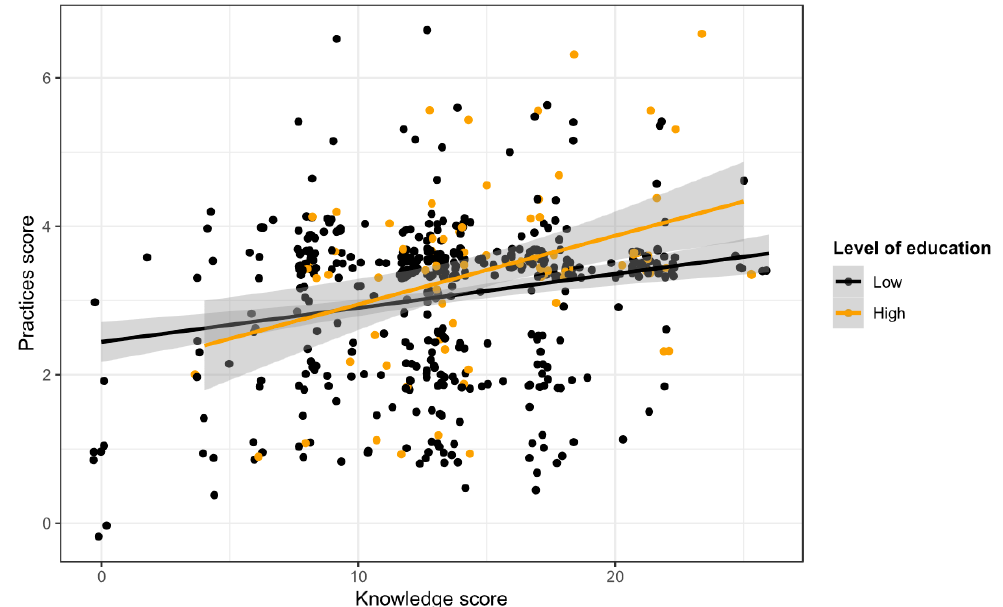
Figure 4. Relationship of knowledge and practices score by level of education. Small random noise was added to avoid over-plotting.